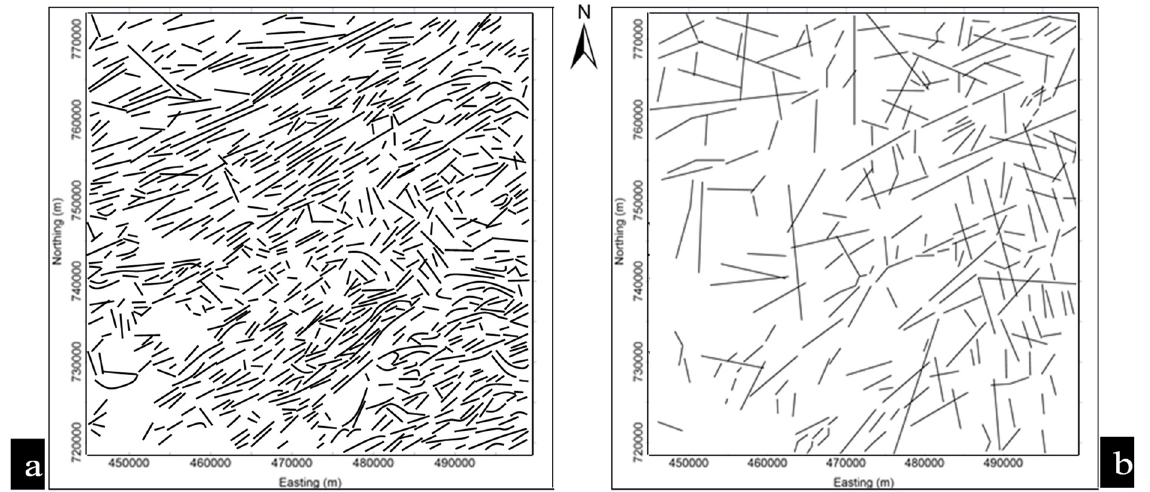
Figure 8. Lineament maps extracted from ( a ) SF and IL and ( b ) the GIS results.